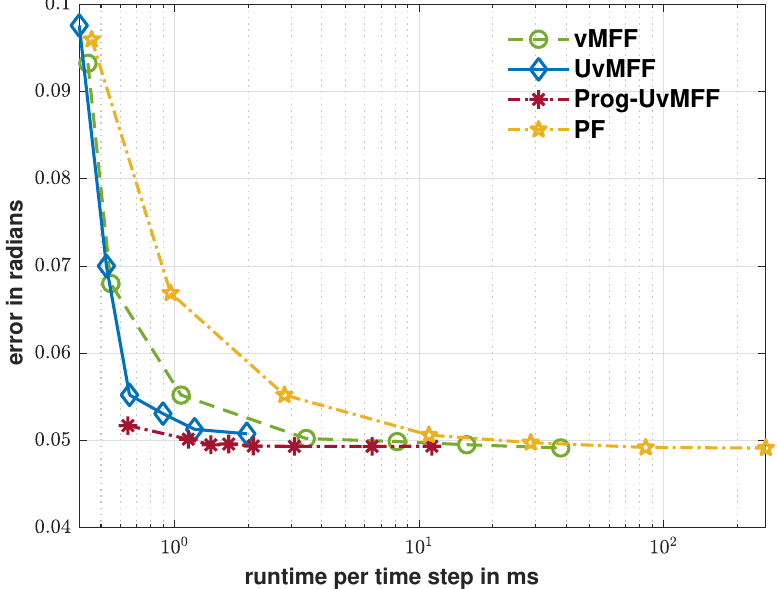
Figure 6. Error over runtime for the evaluated